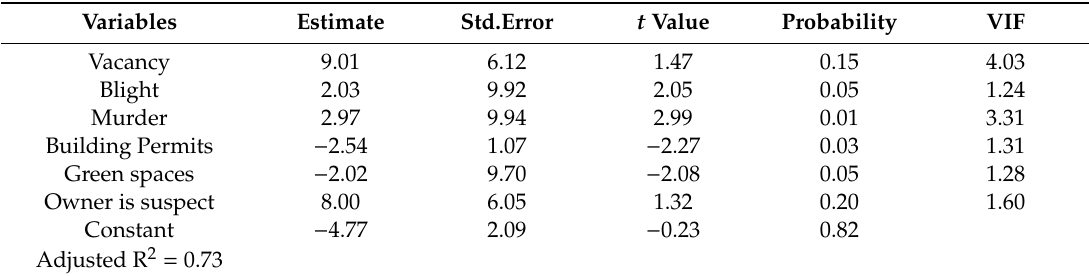
Table 5. Regression of best fitting model across categories of